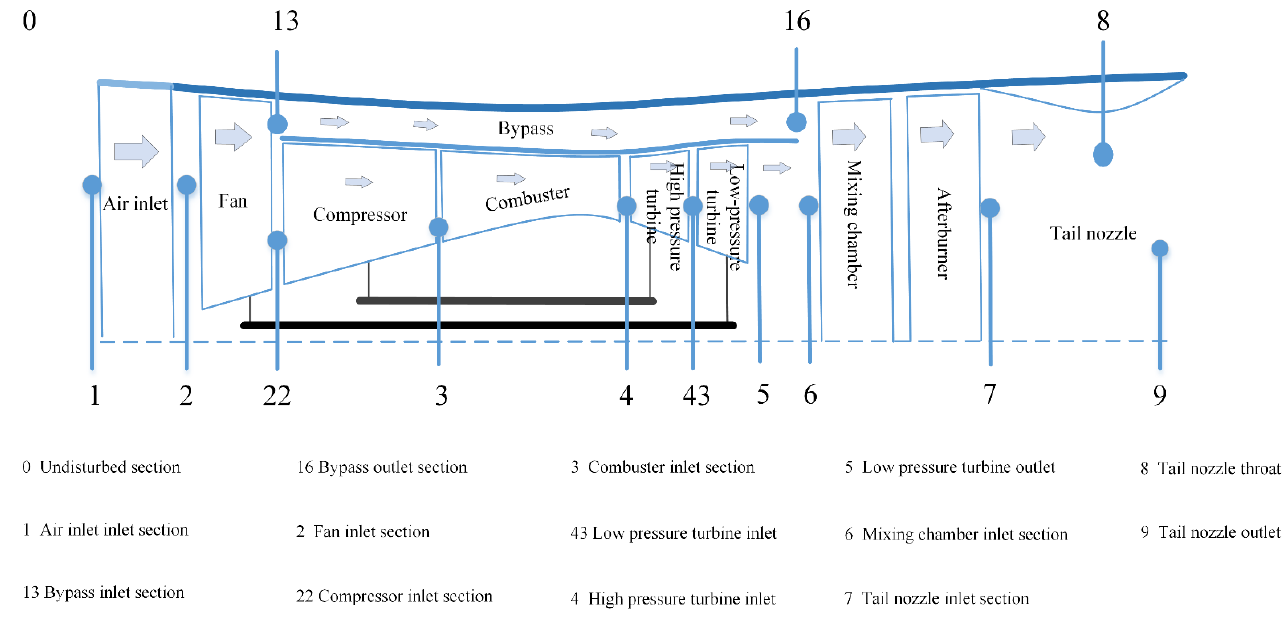
Figure 1. The cross-sectional schematic diagram of a turbofan engine.